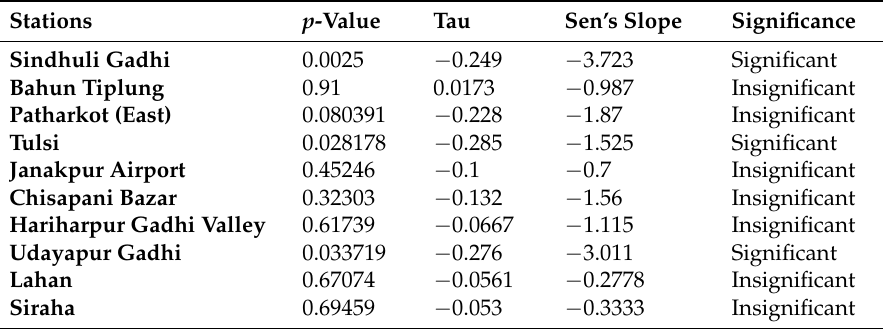
Table 8. Post − monsoon Rainfall